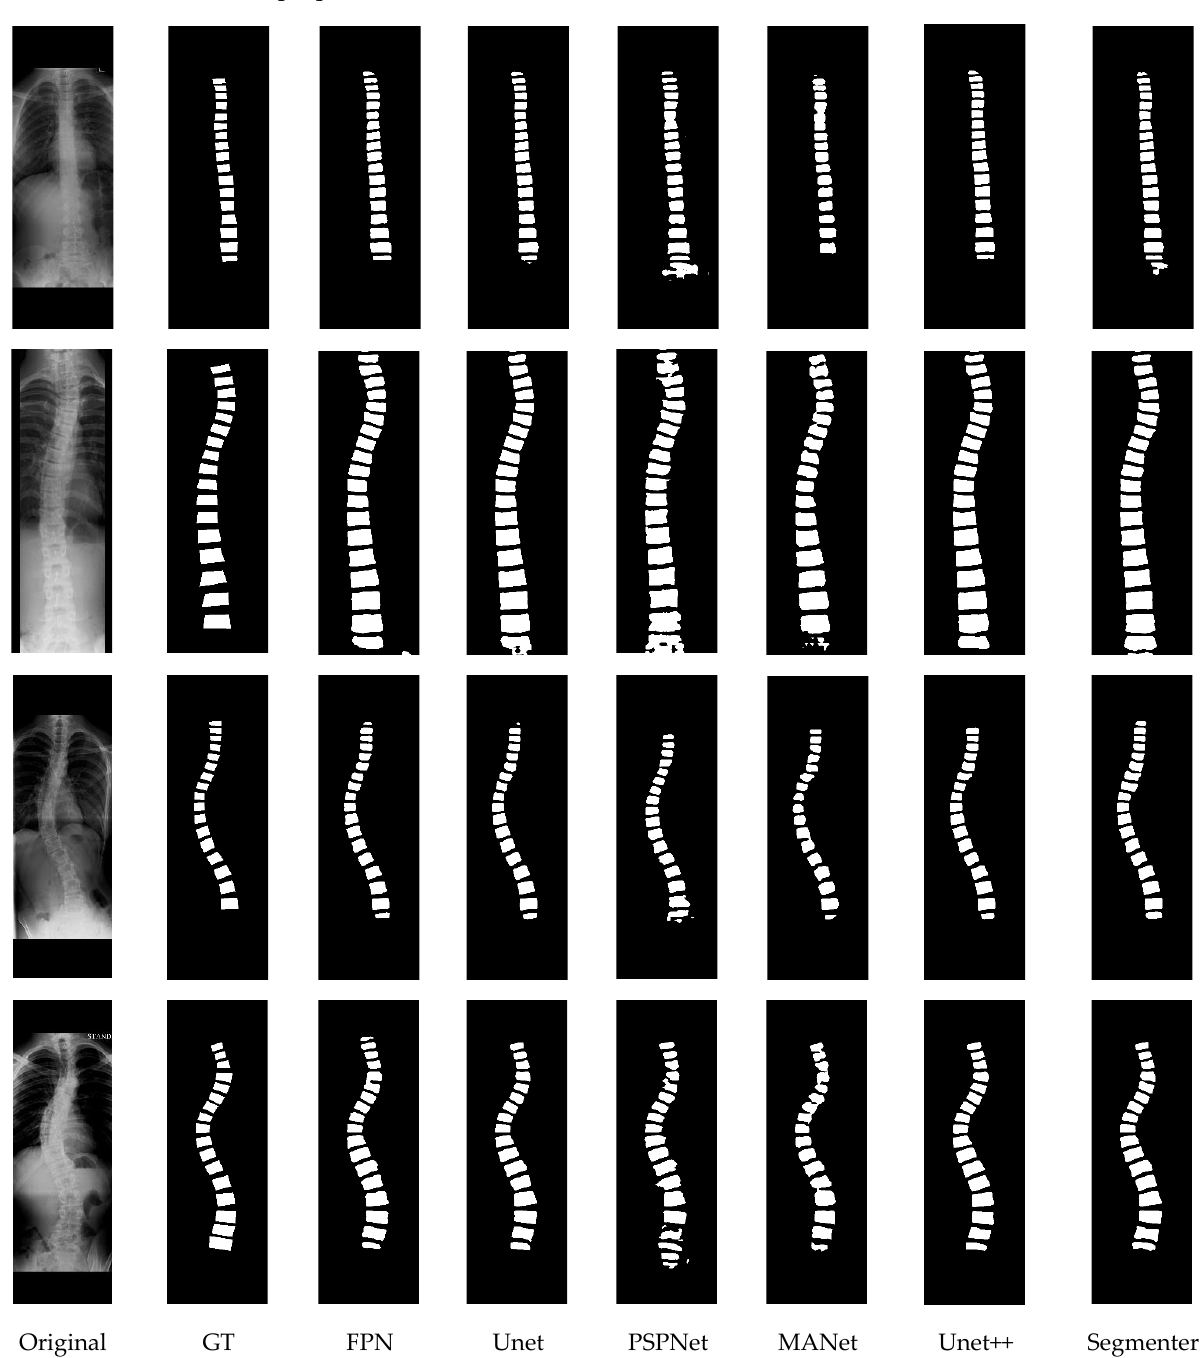
Figure 14. The visual comparison of different segmentation networks. GT: ground truth.